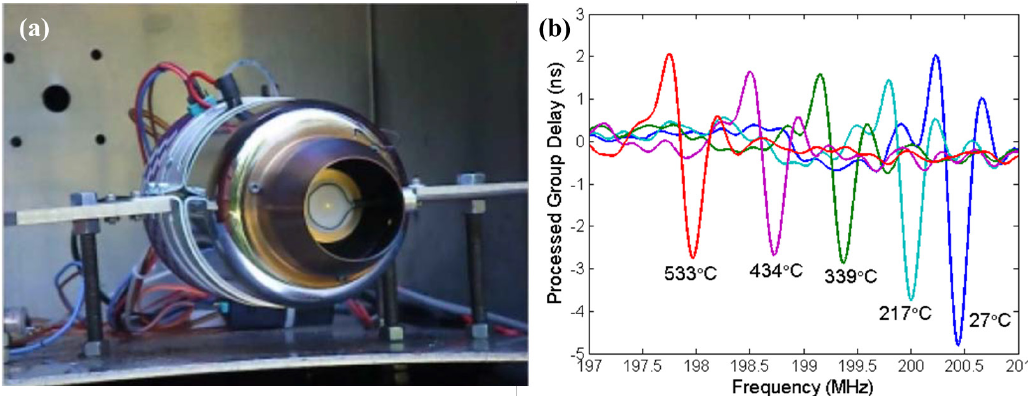
Figure 9. ( a ) SAW sensors mounted on rotating disc of the IBR; ( b ) real-time temperature measurement results during the JetCat operation [66] (copyright 2011 by the